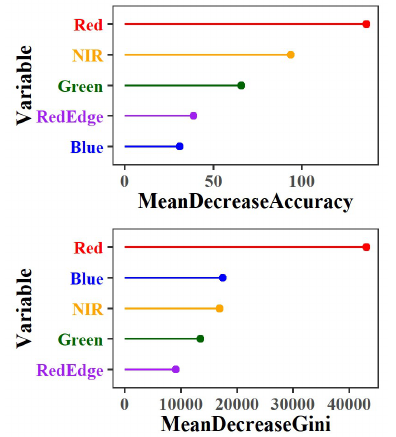
Figure 5. Random Forest MeanDecreaseAccuracy and MeanDecreaseGini feature importance metrics